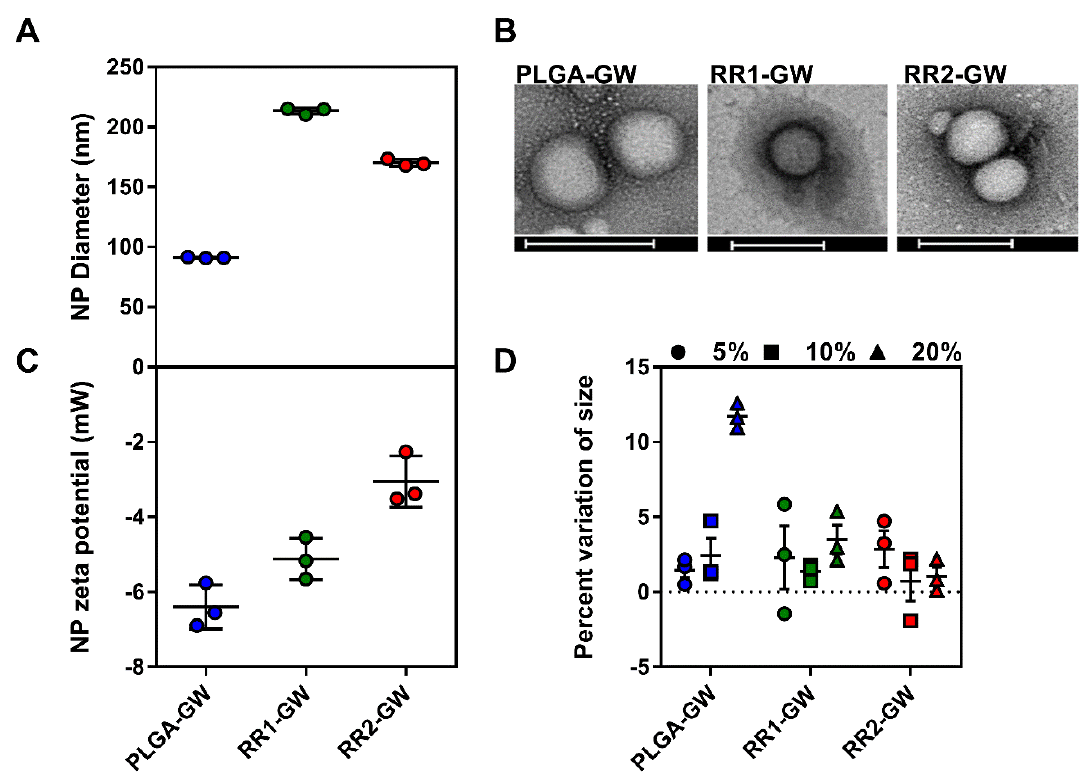
Figure 2. Nanoparticle characterization. ( A ) Hydrodynamic size of three different GW-3965 encapsulated NPs measured by ZetaView and zetasizer ( n = 3). ( B ) Transmission electron microscopy images of GW-NPs showing spherical structure, scale bar = 200 nm. ( C ) Surface charge potentials of GW-NPs measured using zetasizer ( n = 3). ( D ) Stability studies were performed by measuring the GW-NPs size, pre and 1 h post incubation in 5%, 10%, and 20% FBS ( n = 3).